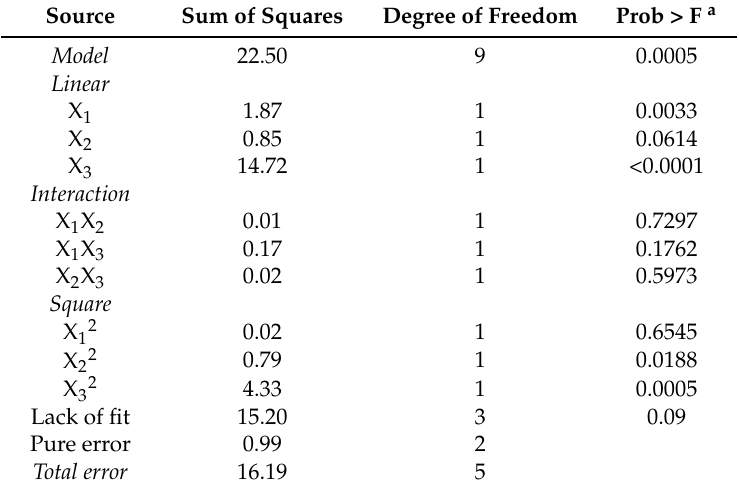
Table 2. ANOVA for synthetic variables pertaining to response percent molar